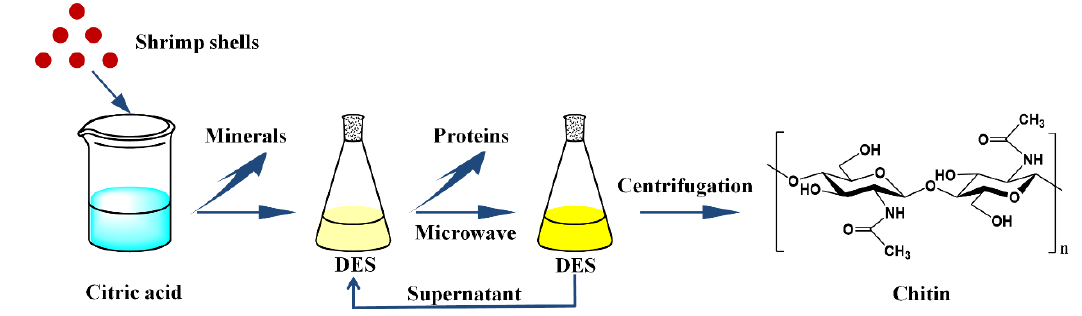
Figure 1. Schematic depiction of two-step separation of chitin from shrimp shells.